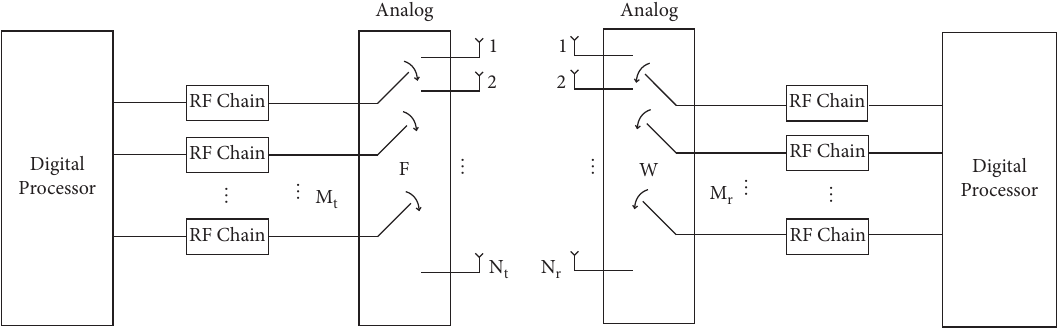
Figure 1: Block diagram of the mmWave massive MIMO communication system with an analog processor implemented using